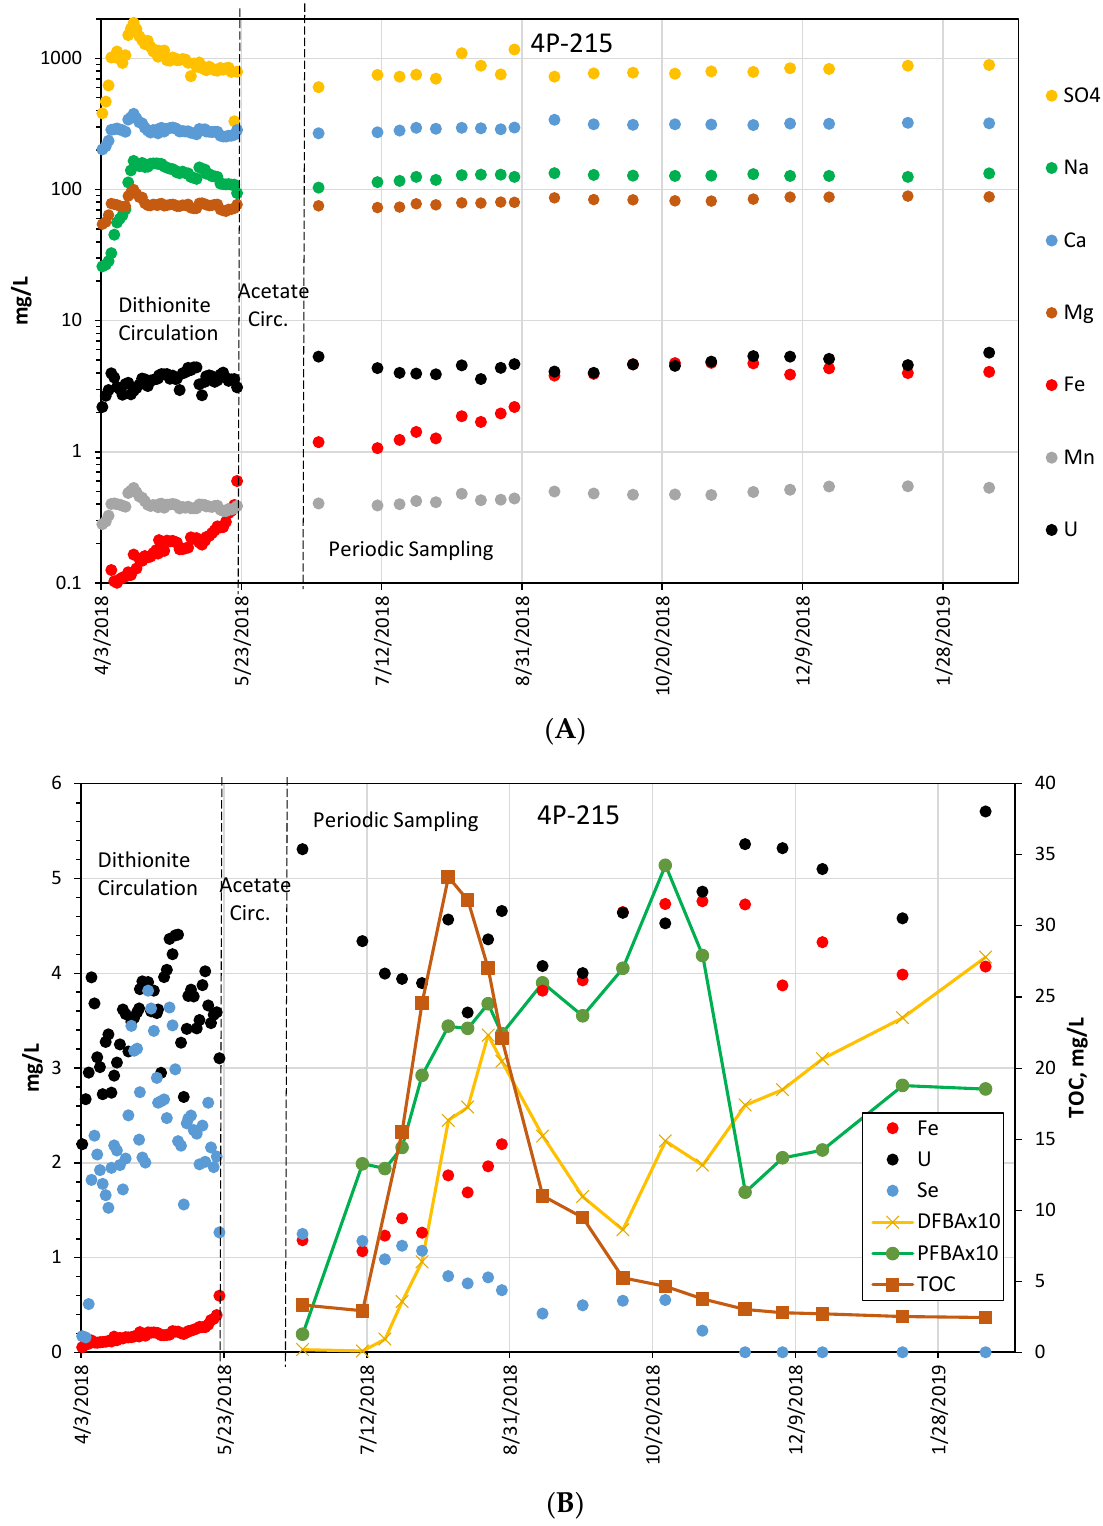
Figure 5 . ( A ) Concentration histories of several key constituents in production well 4P-215 during the amendment test. ( B ) Concentration histories of redox-sensitive constituents (Fe(II), U, Se), TOC (as acetate surrogate), and tracers. Note that difluorobenzoate (DFBA) and pentafluorobenzoate (PFBA) concentrations are ×10.